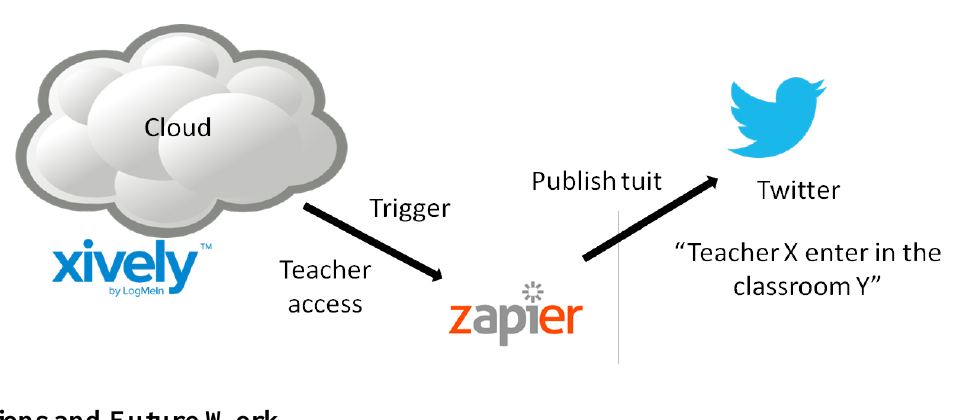
Figure 10. How Zapier sends